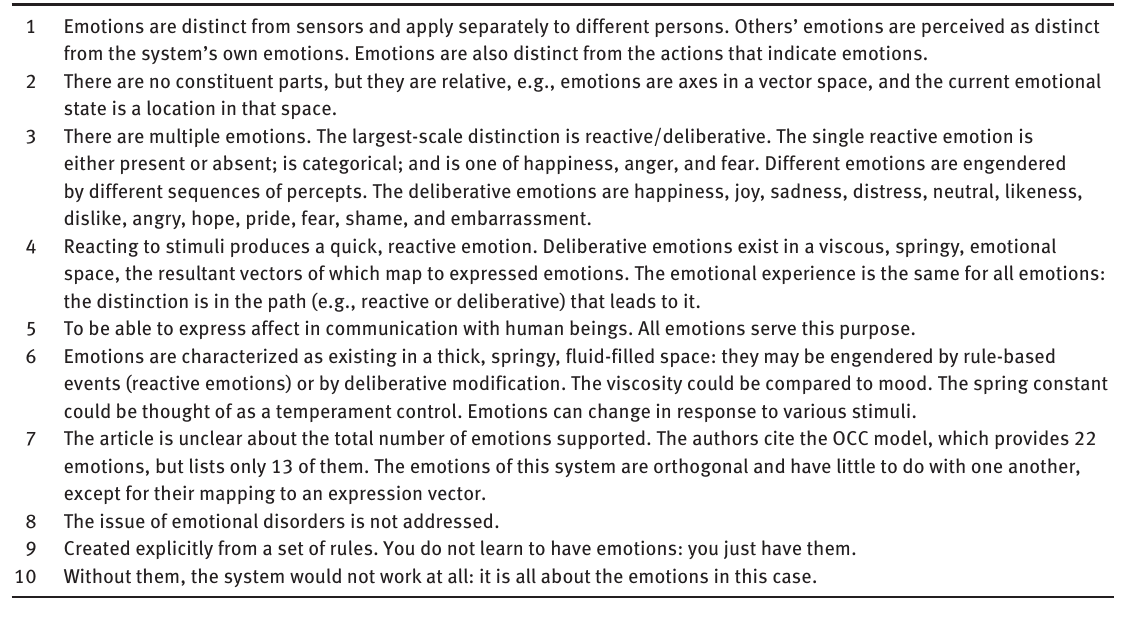
Table 3. Classification of Han Wool Robotics Company